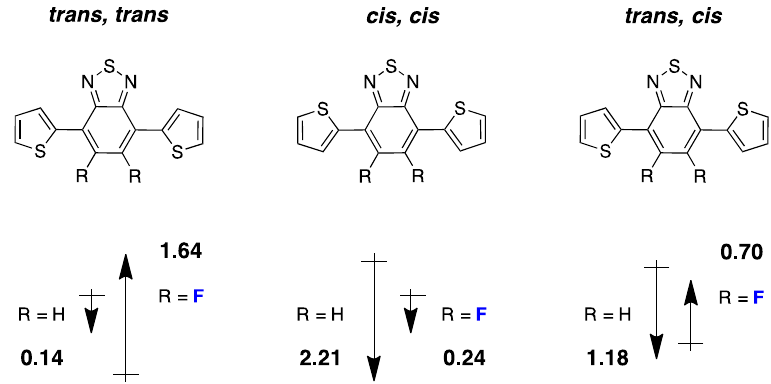
Figure 5. Chemical structure of DTBT (R = H) and DTF2BT (R = F) and the calculated dipole moment for each configuration (adapted with permission from [38]; Copyright 2015 American Chemical Society).